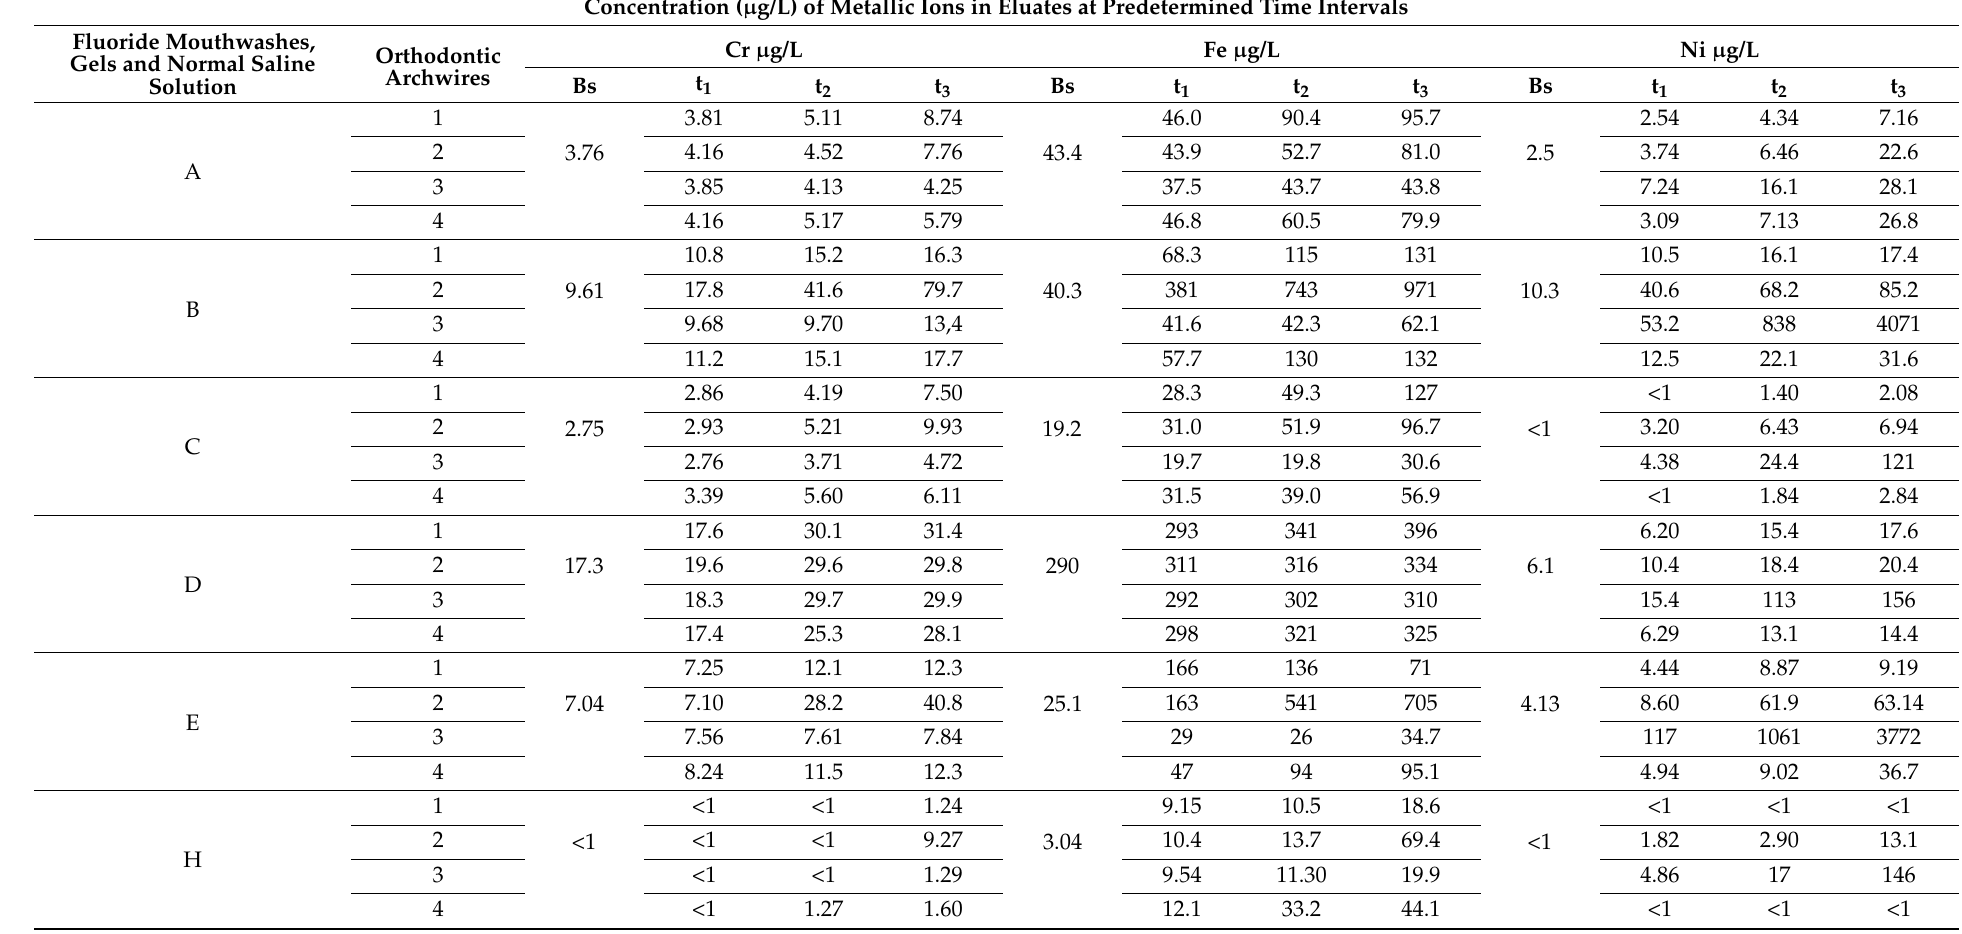
Table 2. Concentration ( µ g/L) of metallic ions present in the eluates, resituated from the immersion of arch sections in the different solutions at predetermined time intervals. The cells showing the greatest release of ions were colored in